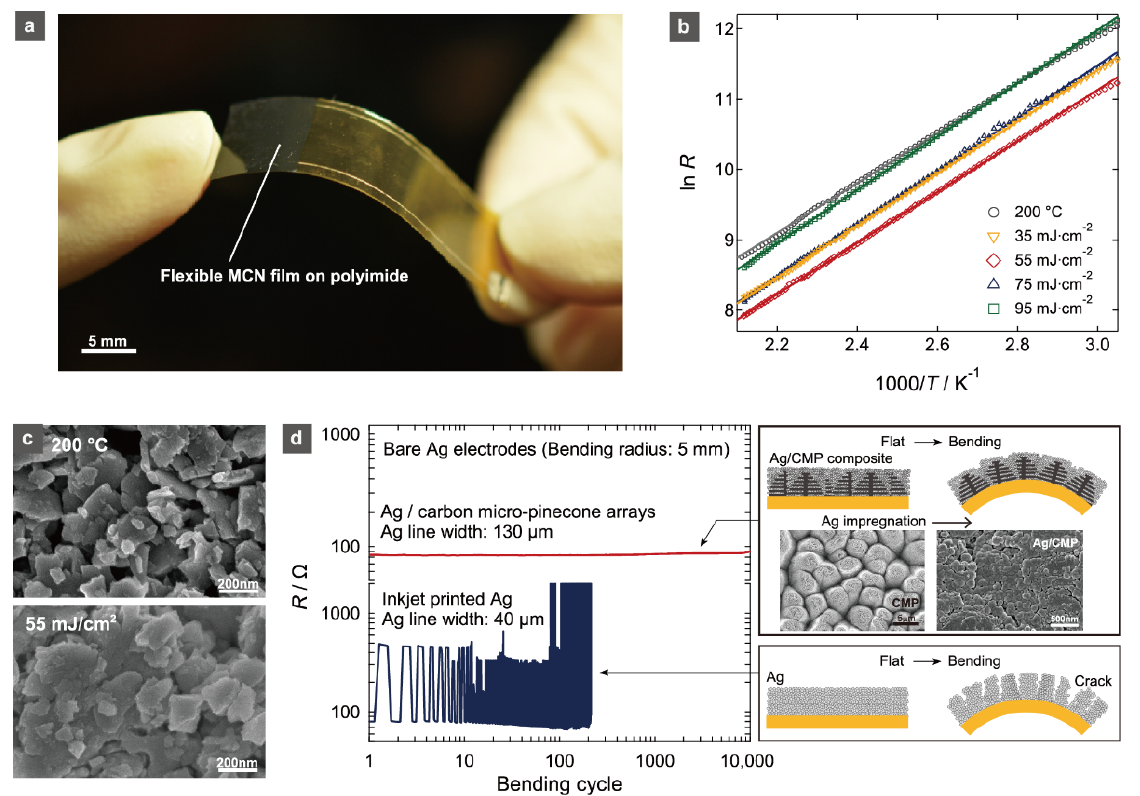
Figure 5. ( a ) Photograph of the MCN film thermistor that was prepared at 55 mJ·cm 2 of Kr laser irradiation on the PI sheet with Ag/carbon micro-pinecone (CMP) composite electrodes. ( b ) Tem- perature dependence of R (Ω) at 27–200°C for the MCN films on PI substrates prepared by drying at 200 °C and laser irradiation at 35–95 mJ·cm −2 for 600 pulses. ( c ) FESEM images of the surface morphology of MCN films prepared by drying at 200 °C, and by KrF laser irradiation at 55 mJ·cm −2 for 600 pulses. ( d ) Changes in resistance ( R ) during bending with a bending radius of 5 mm for patterned lines of the Ag/CMP composite and inkjet-printed Ag. Schematics of the Ag electrodes with, and without, CMP arrays on the flexible substrates in flat and bent states with FESEM images of patterned CMP and Ag/CMP composite on the polyimide substrate. Reprinted with permission from Ref. [49]. Copyright 2017 American Institute of Physics.